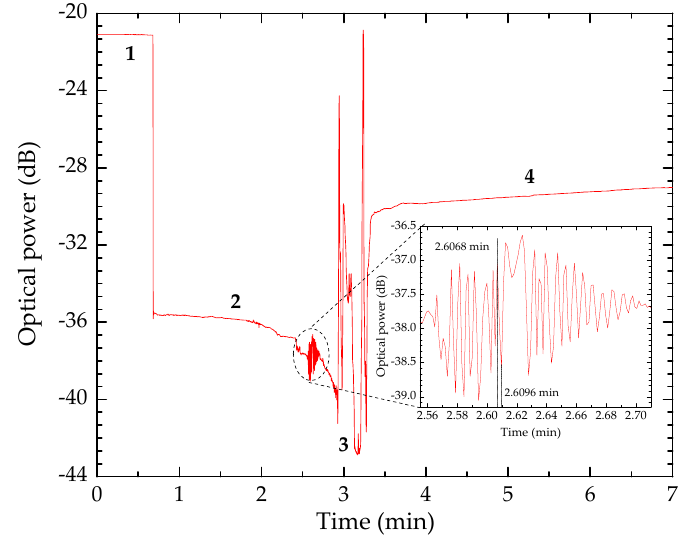
Figure 7. Monitoring of the crystallization process. (1) Addition of the paracetamol sample; (2) air exposure; (3) initiation of crystallization process; (4) stabilization, (zoom in between the steps (2) and